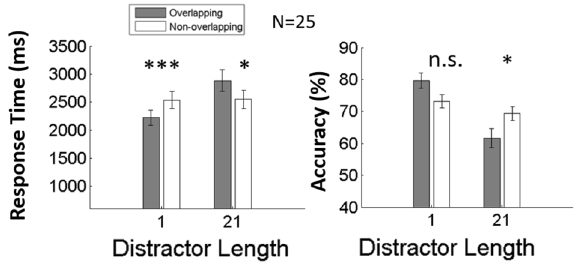
Figure 4. Experimental results of near-threshold performance from 25 participants who met a stricter performance criterion to have their performance within the range [66.67%, 83.31%]. Error bars denote standard errors. ***p < 0.001 and *p <